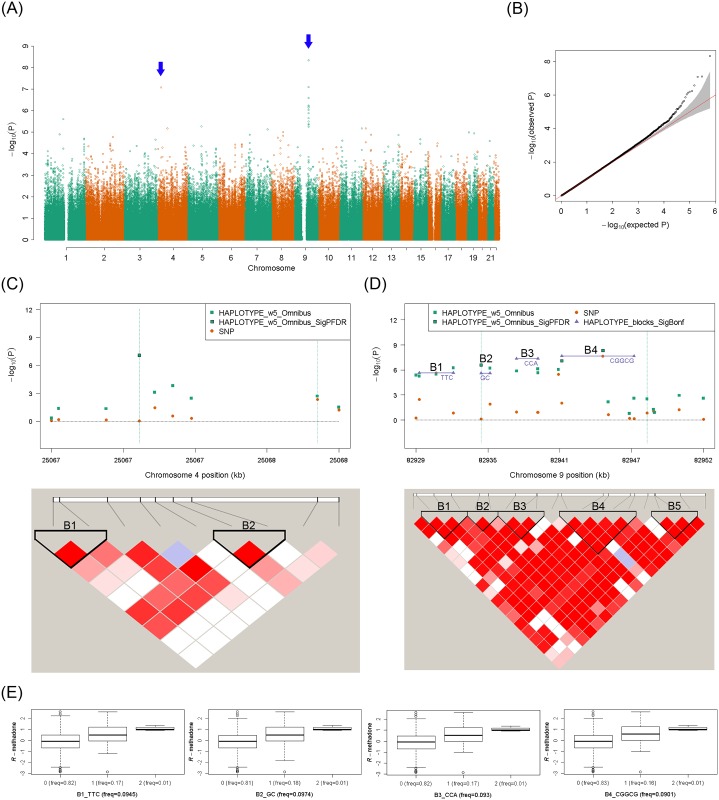
Sliding-window genome-wide haplotype analysis of plasma concentration of R-methadone.(A) Manhattan plot of genome-wide haplotype-based association test. The vertical axis is the raw p values of the omnibus haplotype tests (in a scale of -log10) and the horizontal axis is physical position of the initial SNP of a haplotype in different autosomes. Each point indicates the raw p value of a window. The position of a significant haplotype is indicated by a blue arrow. (B) Quantile–Quantile plot of genome-wide haplotype-based association test. The vertical axis indicates the raw p values of the association tests (in a scale of -log10). The horizontal axis indicates the expected p values of the association tests (in a scale of -log10) under a null hypothesis, i.e., no genetic association. (C) Regional association plot and LD plot on chromosome 4. In the regional association plot, the vertical axis is the raw p values of the association tests (in a scale of -log10) and the horizontal axis is physical position of initial SNP of a haplotype (in unit of kb). Raw p values of single SNPs (orange circle) and haplotypes which were significant after adjusting for false discovery rate [26] (symbol: green square with frame) and were not significant (symbol: green square without frame) are shown. Moreover, haplotypes which passed a multiple-test correction of a false discovery rate [26] in a LD block (purple triangle) are shown. In the LD plot, pairwise LD of SNPs was measured by D’ [27]. SNPs with a strong LD were framed in a black inverse diamond block which was defined according to the confidence interval method [24]. (D) Regional association plot and LD plot on chromosome 9. (E) Distribution of plasma concentration of R-methadone for the haplotypes on chromosome 9 significantly associated with the plasma concentration of R-methadone.